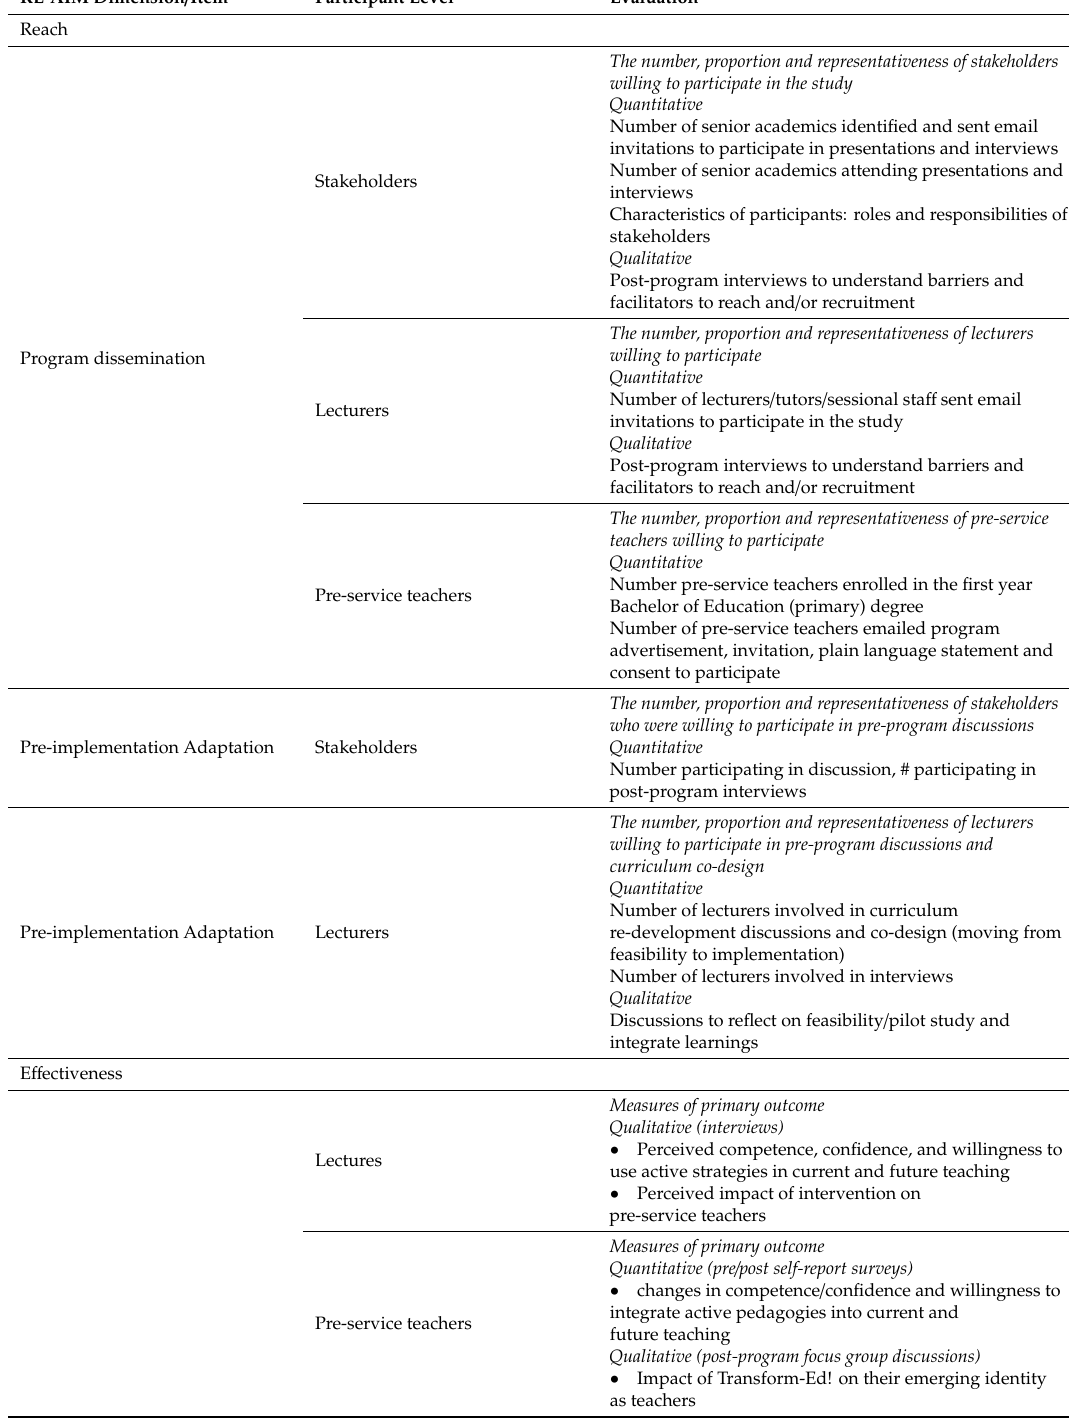
Table 2. The design, implementation and evaluation of Transform-Ed! as guided by the RE-AIM (reach, e ff ectiveness, adoption, implementation, and maintenance)